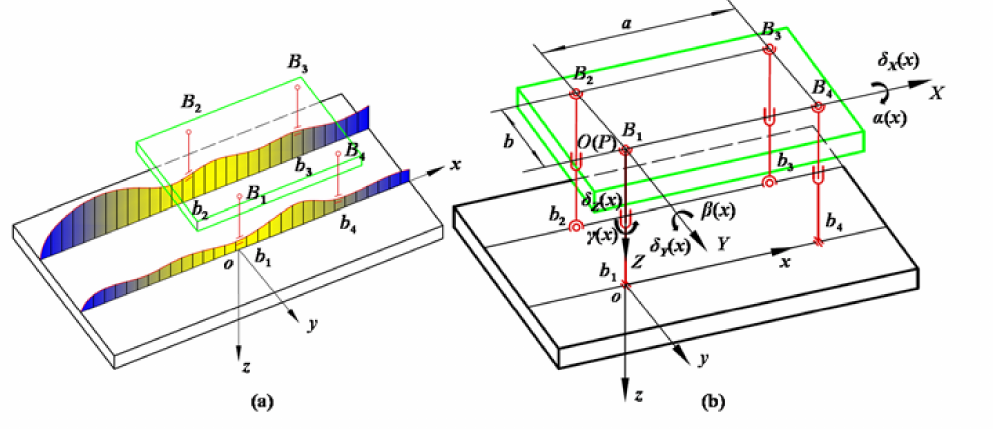
Figure 3. ( a ) Moving error model of guideway, ( b ) simplified parallel mechanism model.